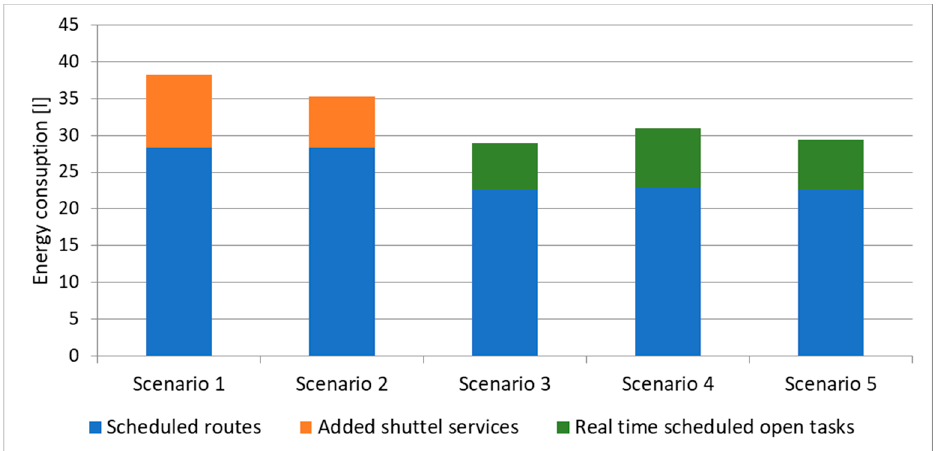
Figure 18. Comparison of energy consumption of the solutions in scenarios.